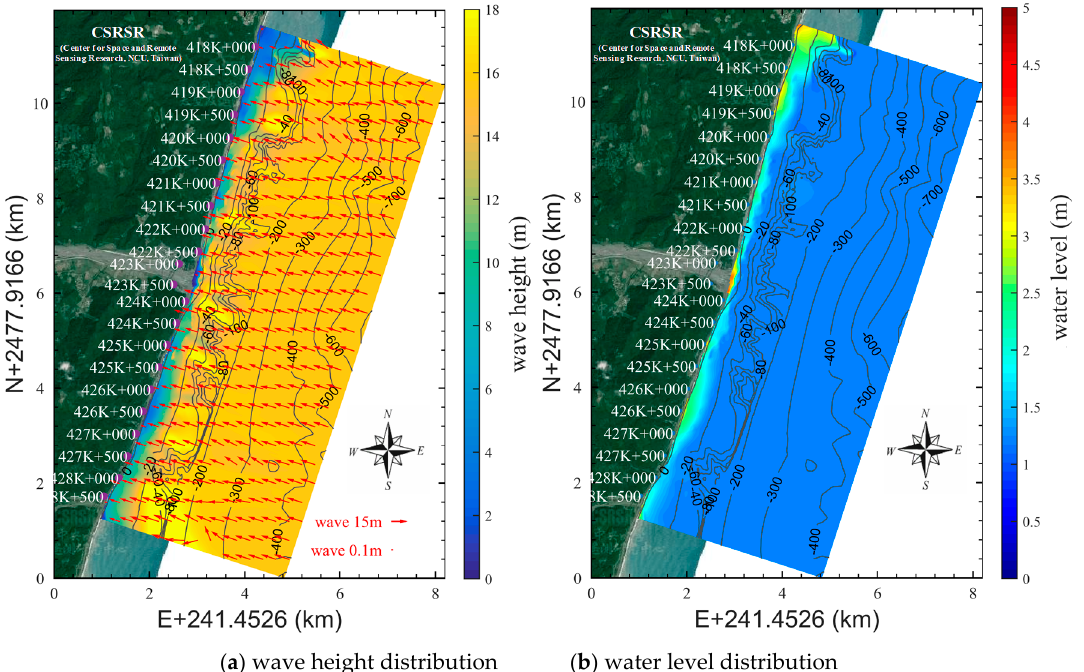
Figure 20. Wave field and water level distribution in Region B.